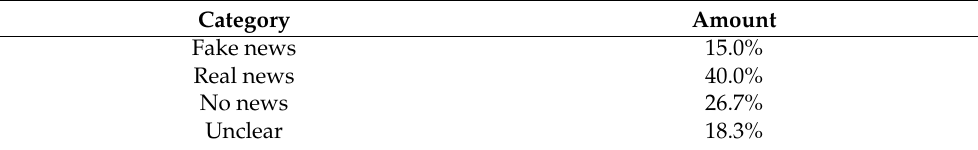
Figure 3. Statistics on sentiment and subjectivity score, as well as on retweet and favorite counts. Table 1. Actual distribution of tweets in the sample drawn from sources known to contain fake